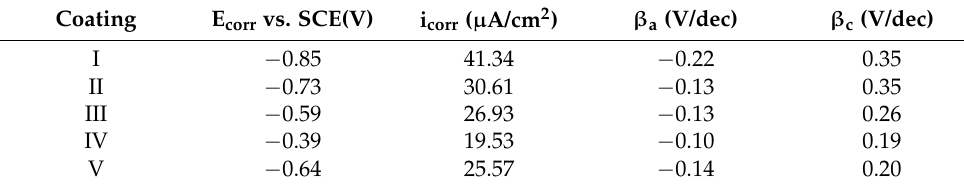
Figure 11. A 0.5 M NaCl solution of alloy coated samples had potential polarization curves. Table 4. The composite coatings’ corrosion potentials and corrosion current densities.